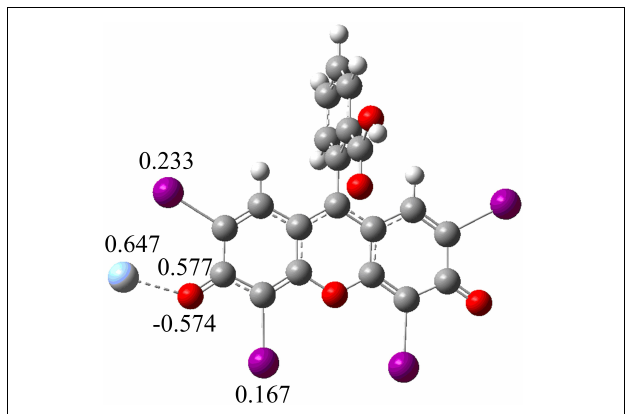
FIGURE 5 | Structure and selected atomic charges of Ag-Ery. FIGURE 7 | Absorption spectra and RRS spectra, concentration of